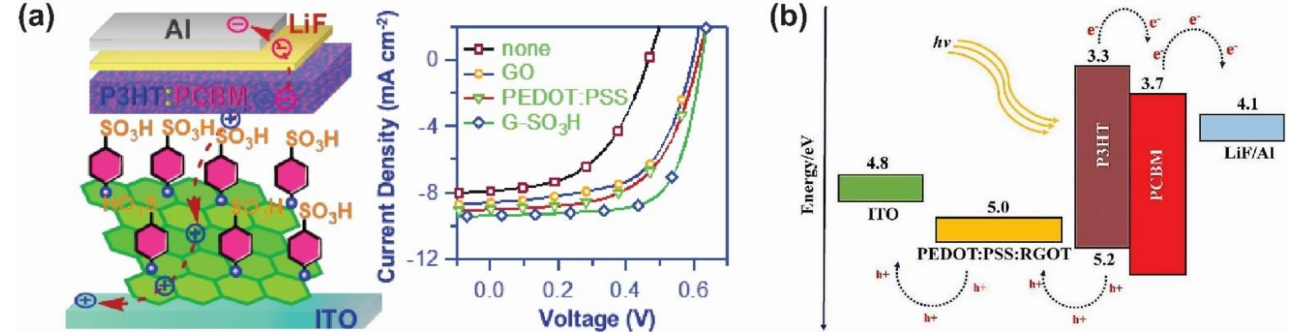
Figure 11. ( a ) J-V curve of the OSCs with G–SO 3 H films as HTL. Adapted with permission from [230]. Copyright 2018, American Chemical Society. ( b ) Energy level diagram of an OSC with RGOT- modified HTL. Adapted with permission from [237]. Copyright 2020, John Wiley and